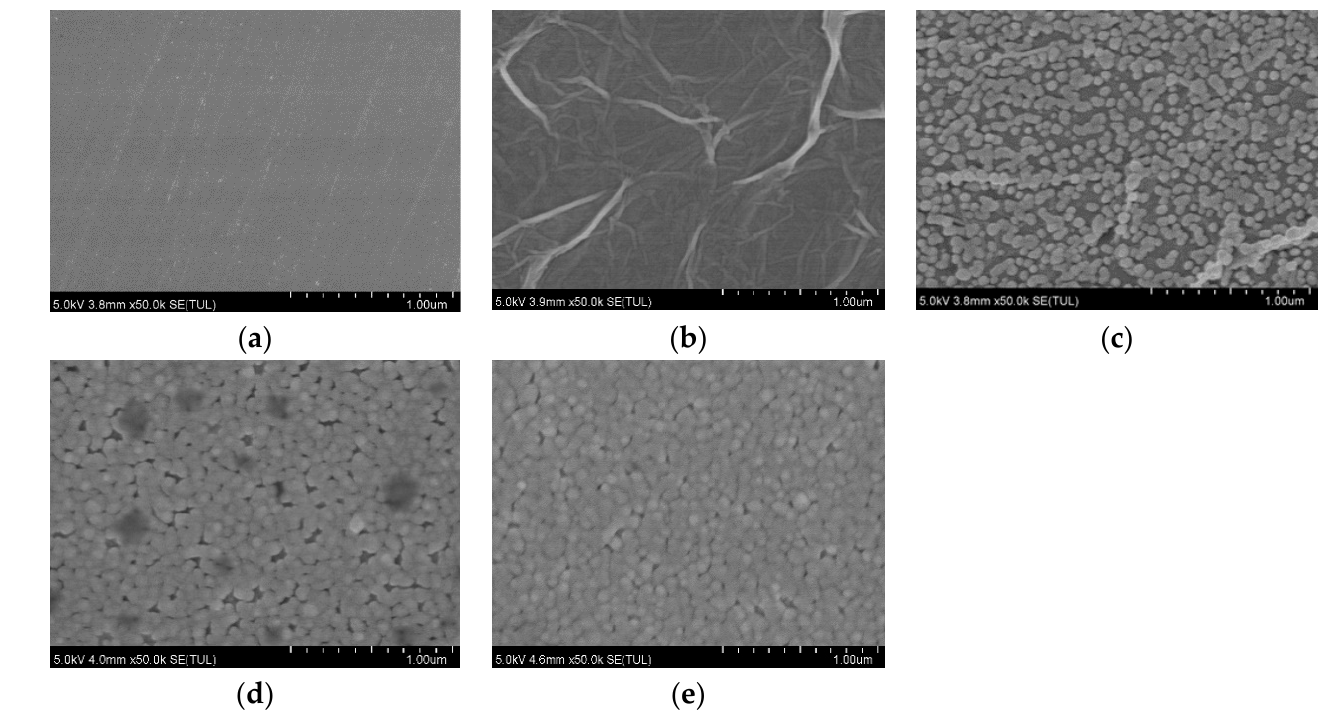
Figure 2. SEM images of bare GCE ( a ), GCE/NGR ( b ), GCE/NGR/AuNPs ( c ), GCE/NGR/AuNPs/Sub ( d ), and GCE/NGR/AuNPs/Sub-DNAzyme duplex ( e ).